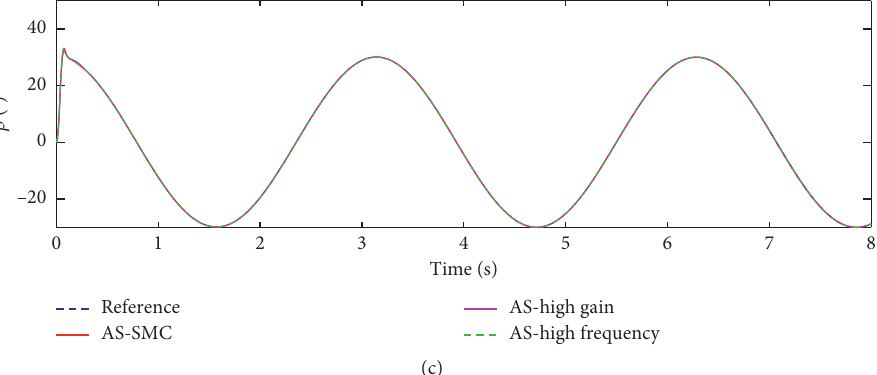
Figure 8: Desired trajectory of three degrees of